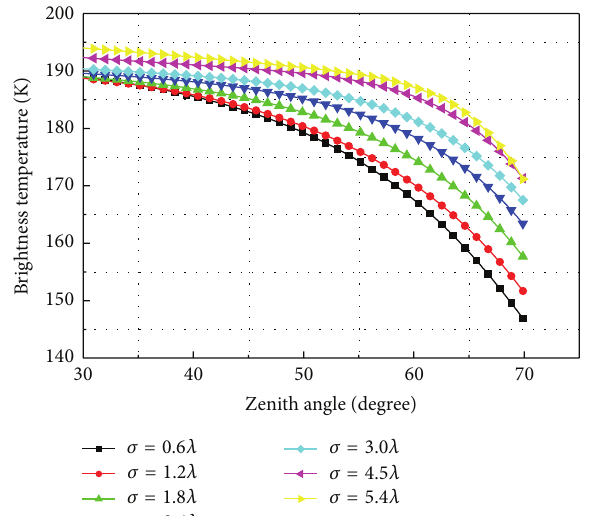
Figure 15: Comparison of different RMS heights, in which the correlative length is set as 10 𝜆 and the relative complex permittivity is set as (3.2, 0.01).